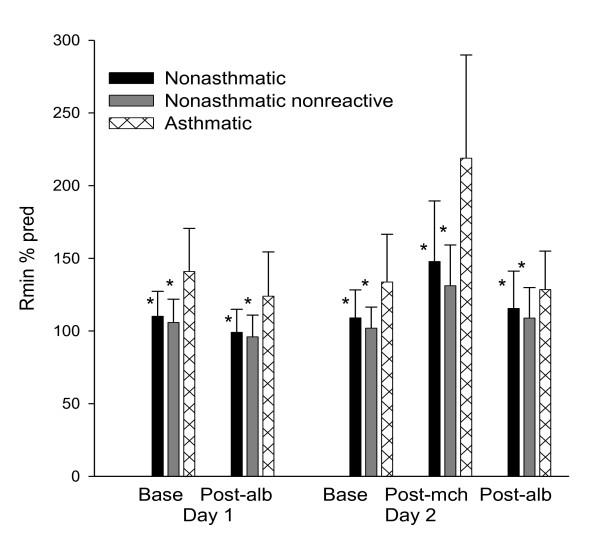
Plot of Rmin % predicted for asthmatic and nonasthmatic subjects. Rmin %predicted for all 34 nonasthmatic (black) and 35 asthmatic (hatched) participants as well as the subgroup of 26 nonasthmatic methacholine nonresponders (gray). *indicates significant difference from asthmatic group in each condition (p < 0.05)